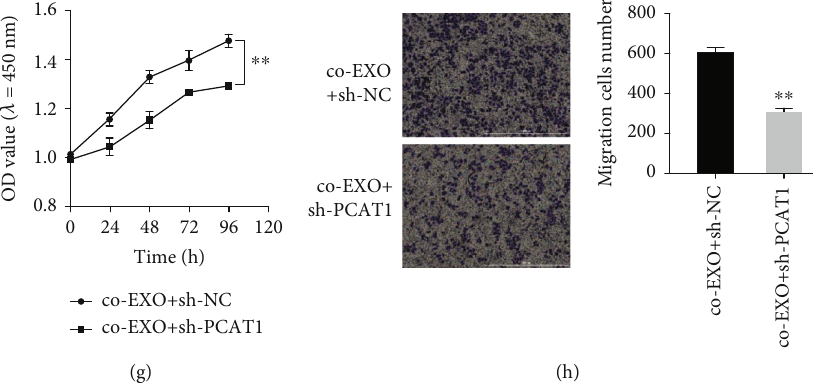
Figure 2: The e ff ect of exosomal PCAT1 on the biological behavior of circulating tumor T84 cells. (a) RT-qPCR was used to detect the expressions of miR-329-3p after co-culture of exosomes with T84. (b) Western blot was used to detect the expressions of Netrin-1 and CD146 after co-culture of exosomes with T84. (c) CCK-8 detected the cell proliferation activity after co-culture of exosomes with T84. (d) Transwell detected the cell migration ability after co-culture of exosomes with T84. ∗∗ P < 0 : 01 , ∗∗∗∗ P < 0 : 0001 vs Control. (e) RT- qPCR. was used to detect the expressions of miR-329-3p in exosomes co-cultured with T84 after PCAT1 knockdown. (f) Western blot was used to detect the expressions of Netrin-1 and CD146 in exosomes co-cultured with T84 after PCAT1 knockdown. (g) CCK-8 detected the cell proliferation activity of exosomes and T84 co-cultured after PCAT1 knockdown. (h) Transwell detected the cell migration ability of exosomes and T84 co-cultured after PCAT1 knockdown. ∗∗ P < 0 : 01 , ∗∗∗∗ P < 0 : 0001 vs